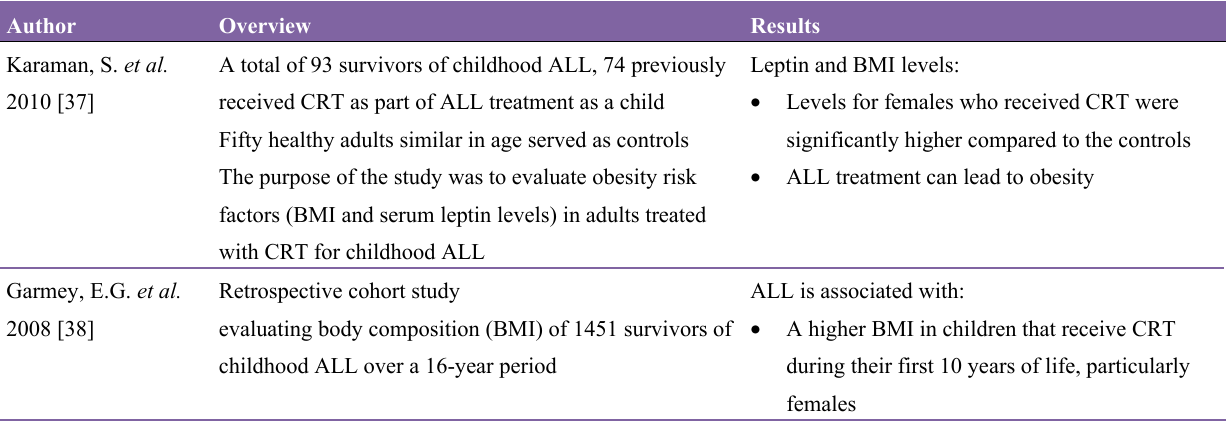
Table 2. Overview of nutrition-related pediatric oncology—studies of body